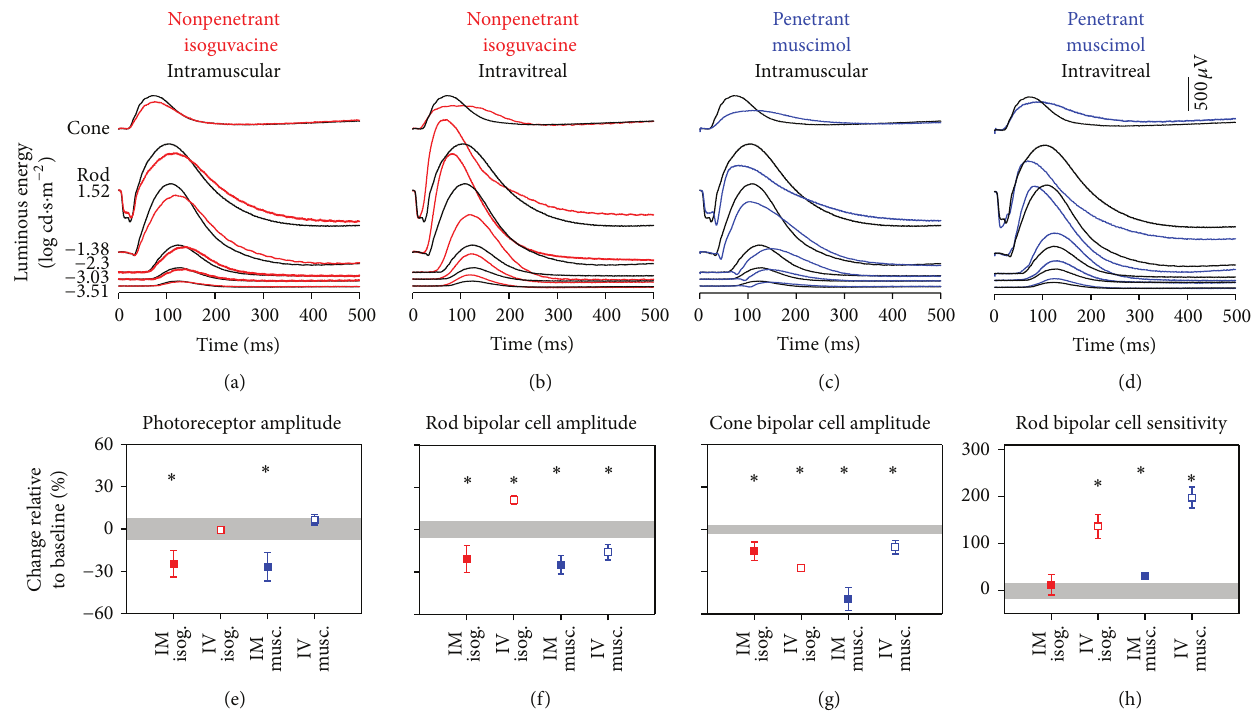
Figure 2: Retinal electrophysiology following anaesthetised isoguvacine/muscimol dosing. ERG responses in anaesthetised animals ((a)– (d), 𝑛 = 5 for each drug group) at baseline (black lines, average anaesthetised groups) compared to (a) intramuscular and (b) intravitreal isoguvacine (red) and (c) intramuscular and (d) intravitreal muscimol (blue). (e)–(h) summarise ERG parameters (average ± SEM) following isoguvacine or muscimol injections via different routes (see method for details). Grey areas indicate 95% CI of the particular ERG parameter in all anaesthetised baseline recordings. Note the different scale bar in (h). ∗ 𝑝 < 0.05